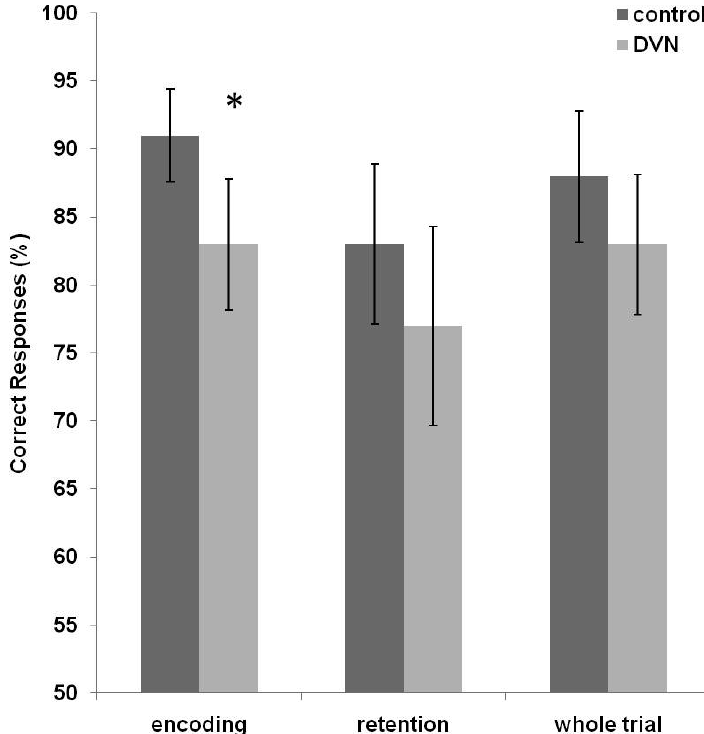
Figure 2 Percentage of participants’ correct responses in the three groups (encoding, retention interval, whole trial), in conditions with dynamic visual noise (DVN) and without noise (Control) * p < .05. Error bars represent standard errors of